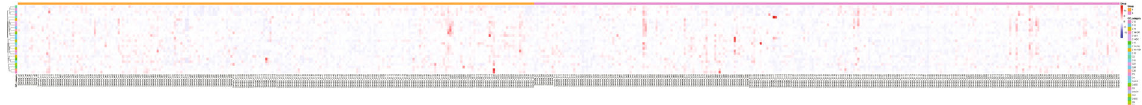
Figure 1: Group A represents the non-DPN group, and Group B represents the DPN